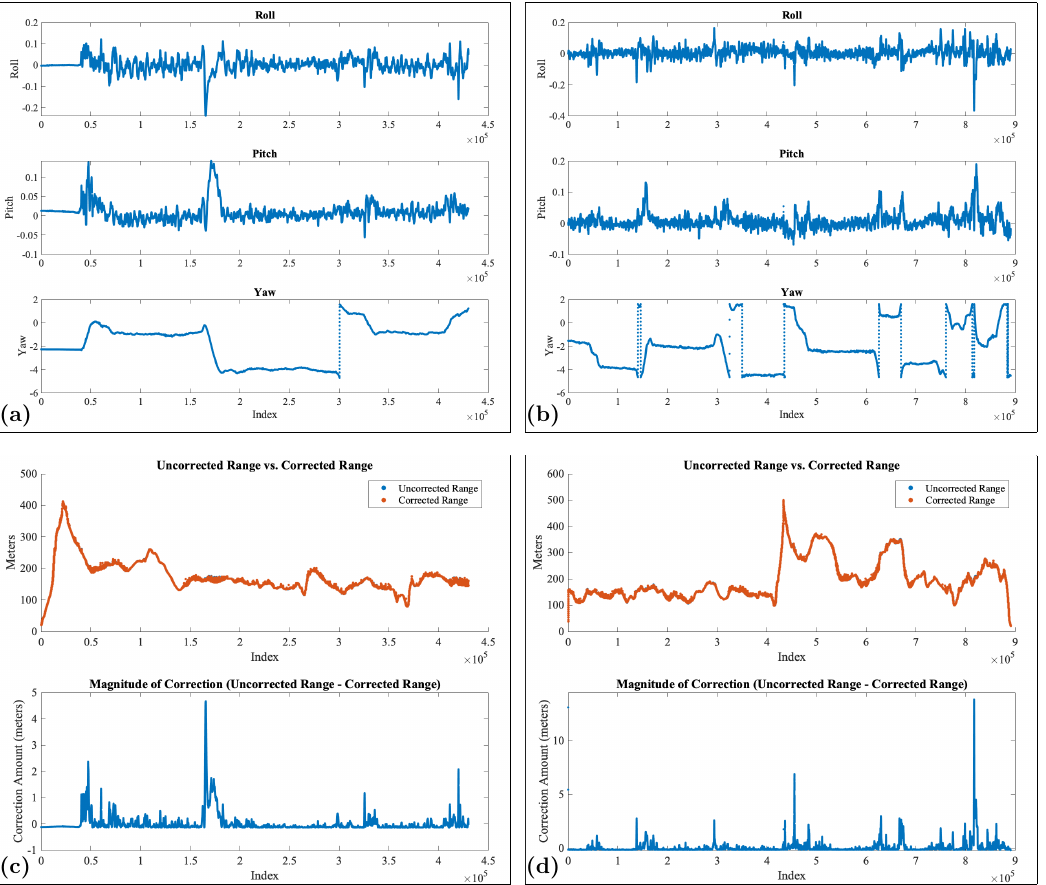
Figure 6. IMU values and IMU-corrected ULS ranges. Negribreen validation campaign. Flight 2, 13 August 2019. ( a , b ) IMU values (roll, pitch and yaw) for flight2, part1 ( a ) and flight2, part2 ( b ). ( c , d ) Range correction (total corrected and uncorrected range and magnitude of correction) for flight2, part1 ( c ) and flight2, part2 ( d